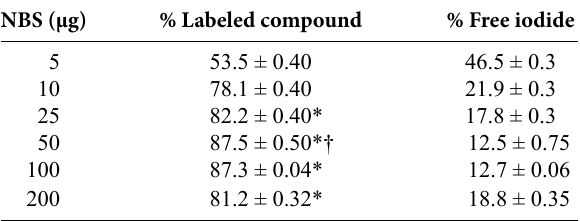
Values represent the mean ± SEM, n = 6 * Significantly different from the initial values using student’s t-test (P<0.05). † Significant- ly different from the previous values using student’s t-test